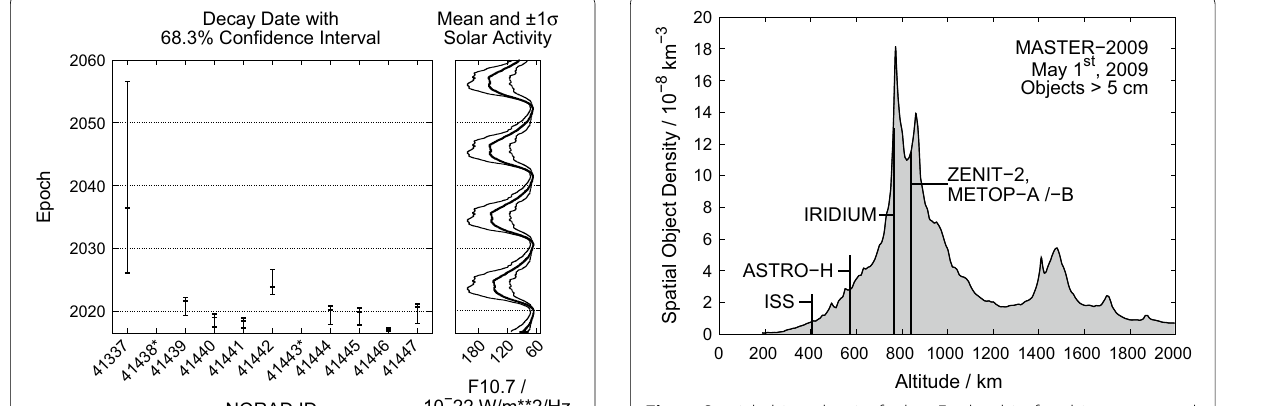
Fig. 7 Spatial object density for low Earth orbits for objects 5 cm and larger. The plot was created using ESA’s MASTER-2009 software (v7.2). The spatial object density peak just below 800 km is created by the fragments from the two debris clouds of the Iridium 33 and Cosmos 2251 spacecraft which collided in early 2009. The peak just above that altitude is the debris from the Chinese anti-satellite test in which the meteorology satellite Fengyun 1C was deliberately destroyed by a ground-to-space missile (Liou and Johnson 2009; Johnson et al.